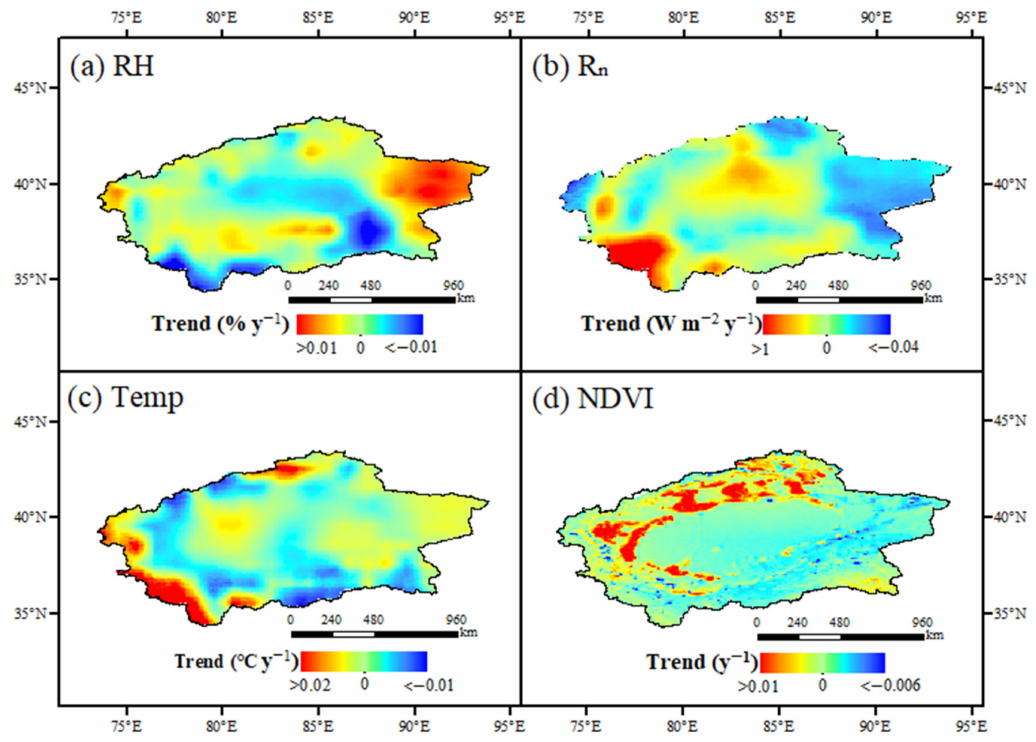
Figure 6. Variation trend of Temp, Rn, RH, and the NDVI in southern Xinjiang from 1982 to 2015. ( a–d ) describe the variation trend of relative humidity, net radiation, temperature and NDVI, respectively.